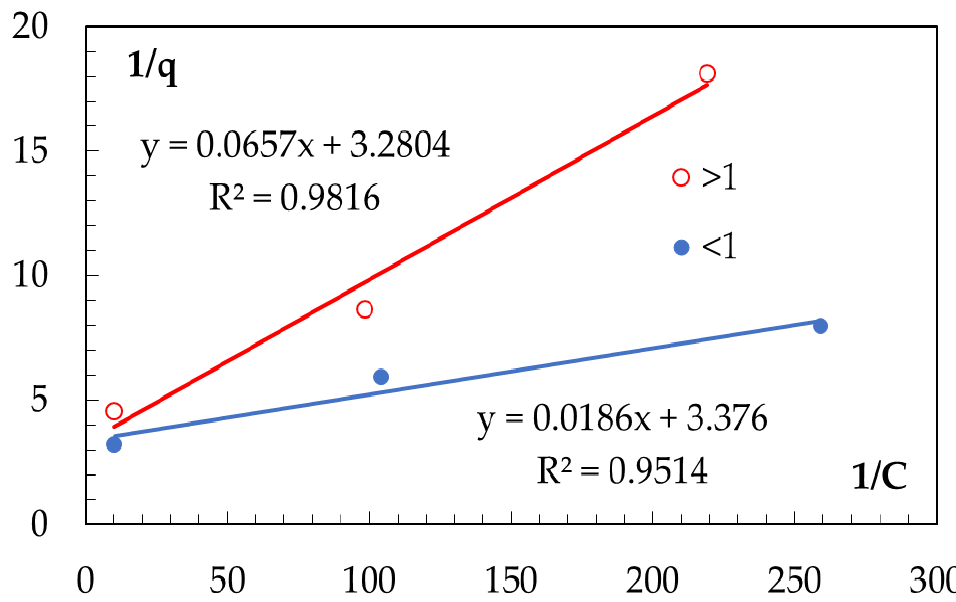
Figure 5. Linear forms of Mn 2+ sorption isotherms.